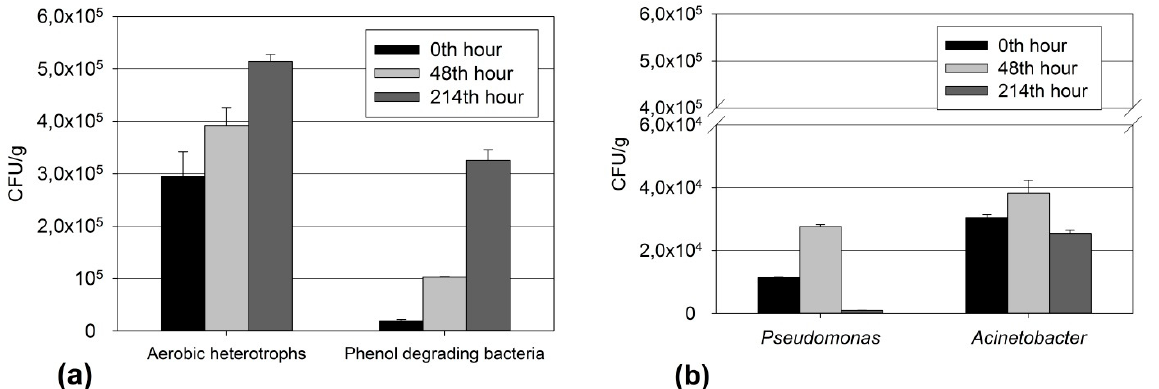
Figure 4. Quantities of: ( a ) aerobic heterotrophic bacteria and phenol ‐ degrading bacteria in the variant without added ND; ( b ) bacteria from genus Pseudomonas and genus Acinetobacter in the variant without added ND.